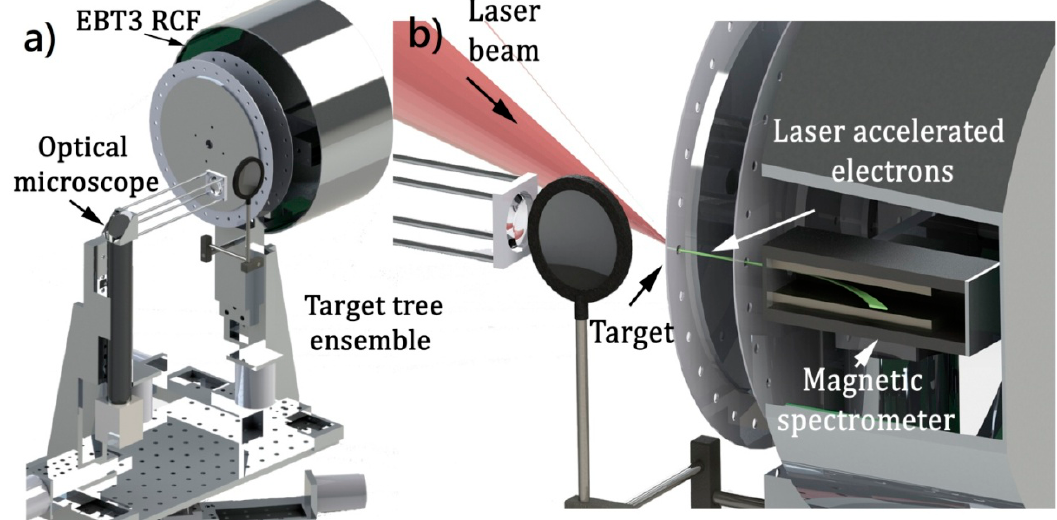
Figure 2. ( a ) Experimental set-up; ( b ) Detailed of the experimental set-up.